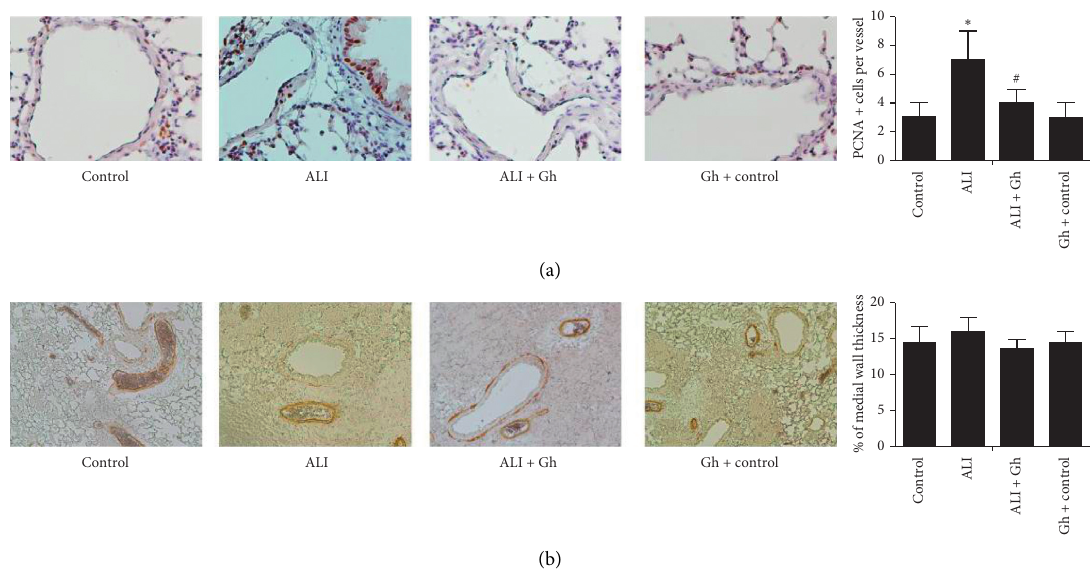
Figure 2: Ghrelin pretreatment reduced the number of PCNA + cells but had no effect on the intima-media arterial wall thickness of LPS- induced ALI rats. (a) Representative images of PCNA + smooth muscle cells of the four groups at 200x magnification and the corresponding histograms. The nuclei of PCNA + cells were stained brown, while those of PCNA − cells appeared blue. (b) Representative images of an anti- α -smooth muscle actin- ( α -SMA-) stained pulmonary artery. The intima-media arterial wall thickness of the lungs of six different rats from each of the four groups was calculated using the following formula: % of wall thickness � (intima-media thickness/external diameter) × 100. Data are presented as the mean ± SD ( n �